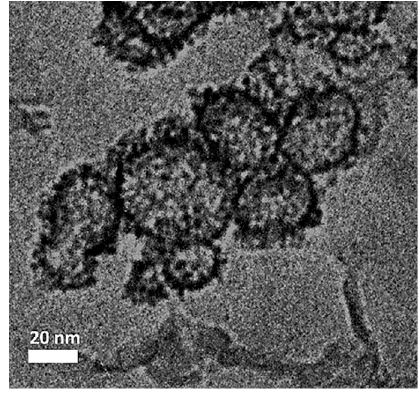
Figure 6. The TEM images of Co 3 O 4 @Pt/GN.